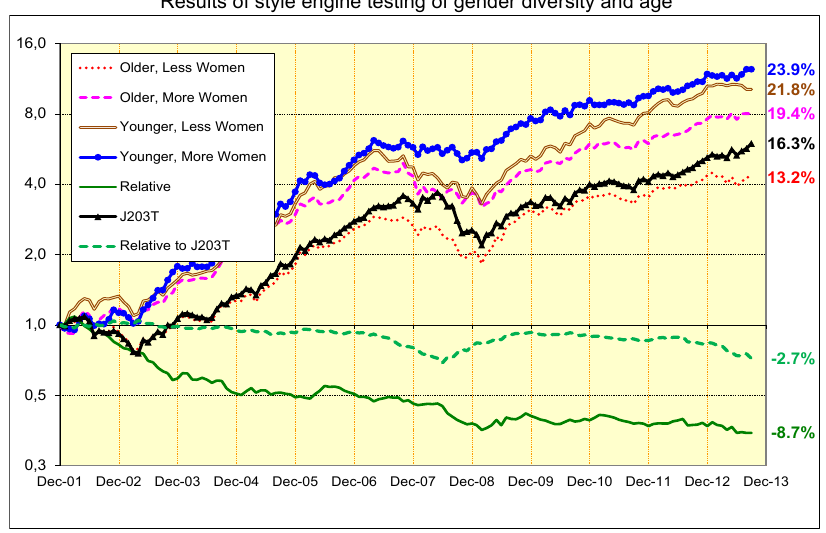
Results of style engine testing of gender diversity and